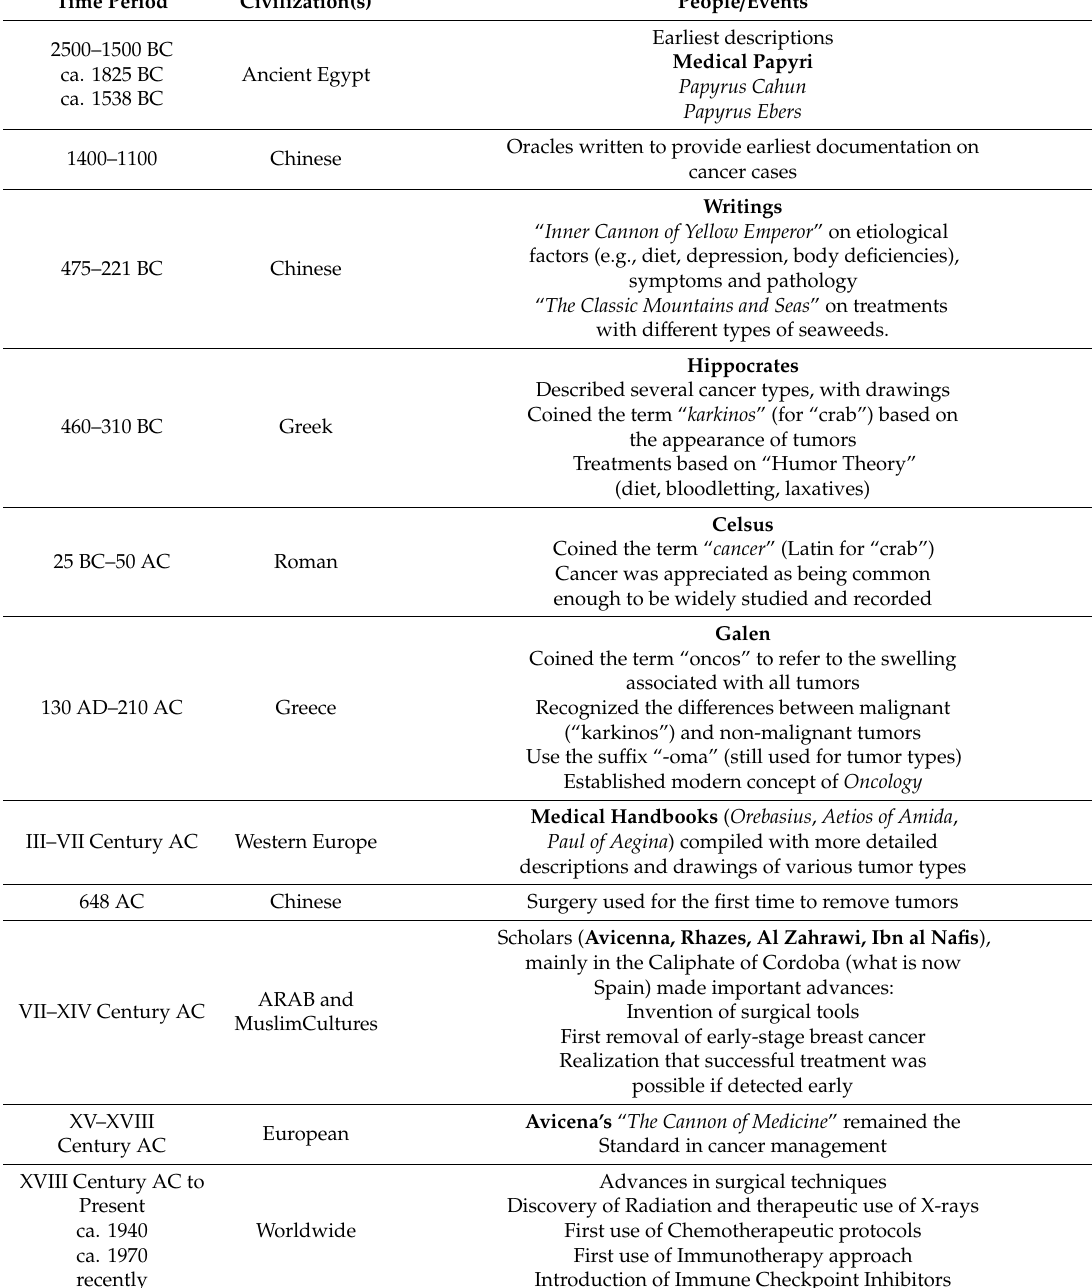
Table 2. Brief history of